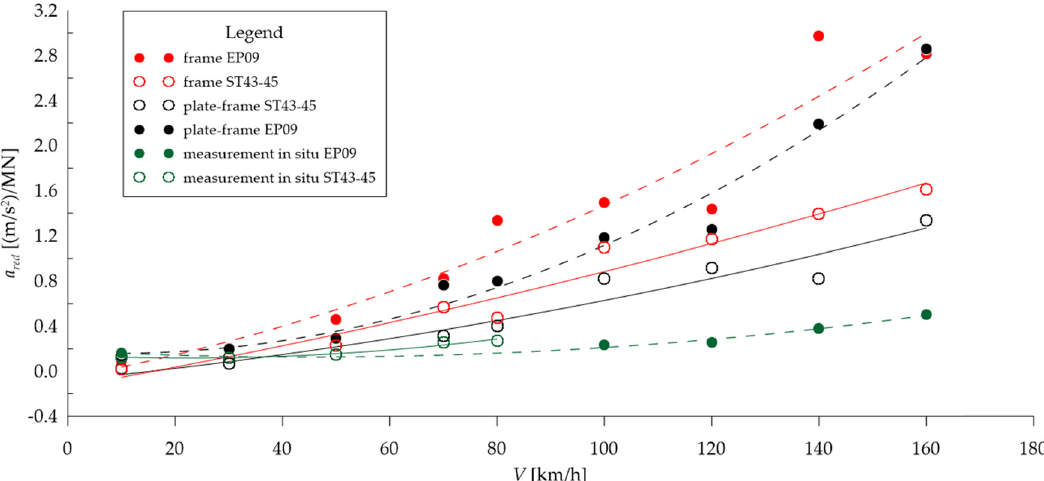
Figure 9: Graph of the reduced values of acceleration a red depending on the locomotive speed v , continuous lines represent trend based on measurements or calculated